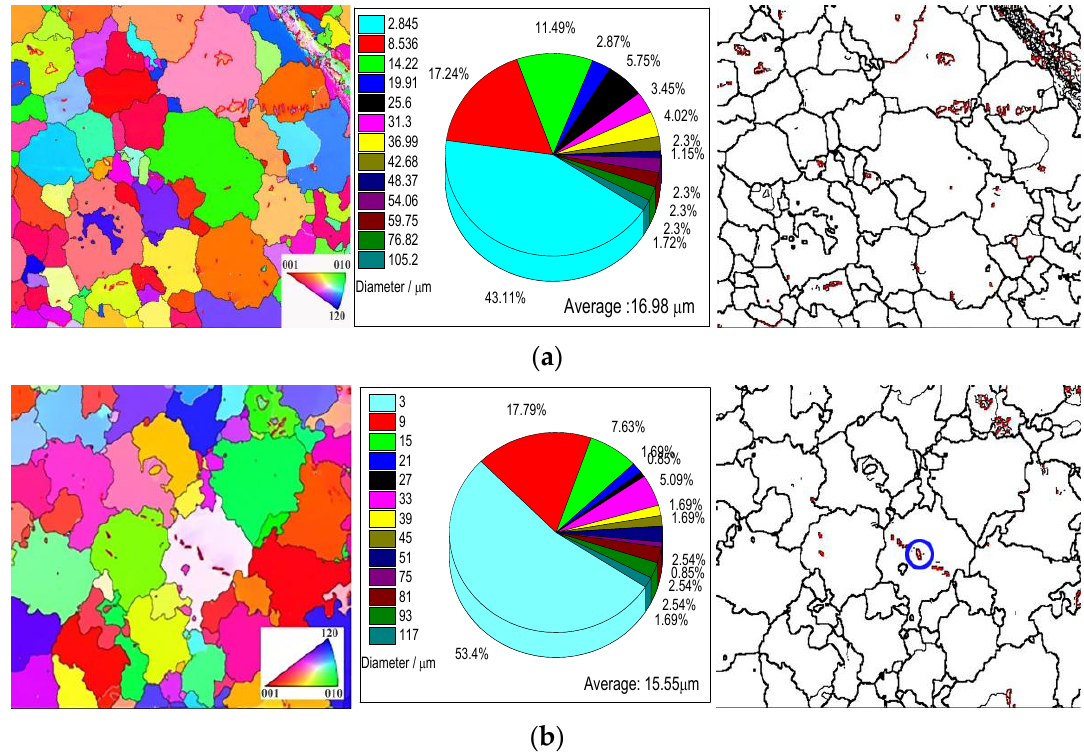
Figure 9. EBSD analysis results of welded joint. ( a ) EBSD results of welded joint with 3 mg/cm 2 coating without magnetic field; ( b ) EBSD results of welded joint with 3 mg/cm 2 coating in the presence of magnetic field.